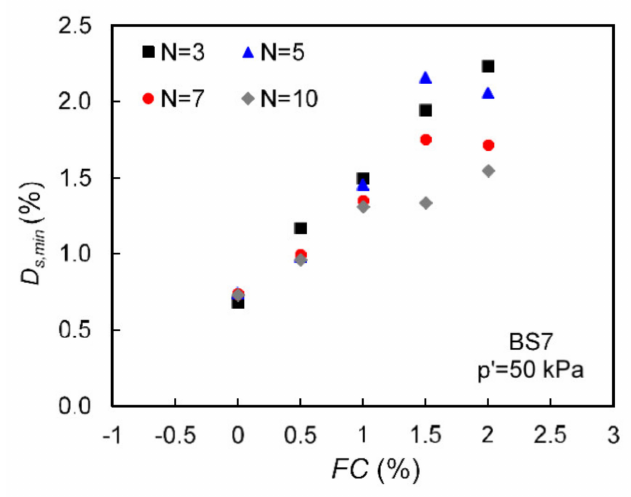
Figure 9. Small-strain damping ratio obtained from different number of cycles (N) used to compute the logarithmic decrement from the free decay curve for specimens with varying fiber content.